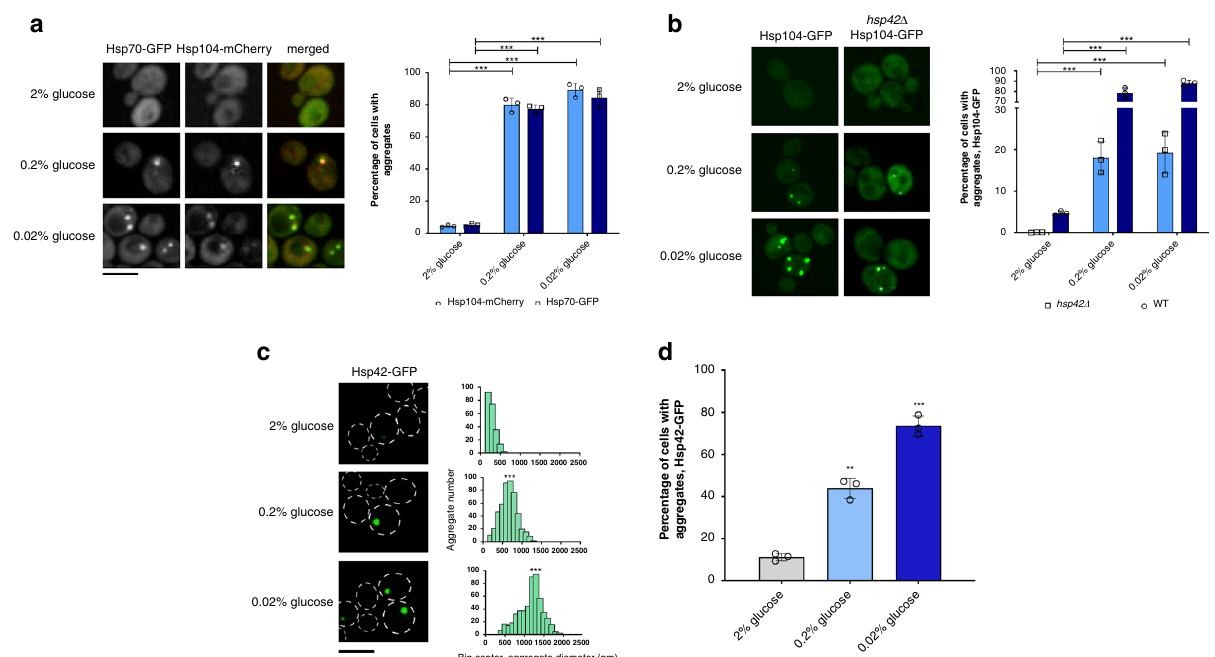
Fig. 4 Proteins are sequestered into Q-bodies during glucose starvation. a Hsp70 colocalizes with Hsp104 in aggregates formed during glucose starvation. The percentage of Hsp70-containing (Ssa1-GFP) aggregates is, on average, 76% in 0.2 and 85% in 0.02% glucose and corresponds to the abundance of Hsp104-mCherry aggregates. b In the hsp42 Δ strain, the percentage of cells with Hsp104-GFP aggregates is reduced in both 0.2% and 0.02% glucose. In a and b , n = 1100 cells were screened for aggregates starting from three independent exponential yeast cultures for each condition. Bar height represents mean ± SD from three separate cultures, each performed in triplicate. The mean of three technical replicates for each biological replicate is displayed as single data points. *** p < 0.001; ** p < 0.01; * p < 0.05 (one-way ANOVA plus Tukey post hoc). The images are representative of three biological replicates, each in three technical replicates. The black bar represents 8 µ m. c The number and the median diameter of Hsp42-bearing aggregates increase during starvation. Data represent binned values of individual aggregate diameters for n = 221, 494, and 541 aggregates from three independent exponential yeast cultures for each condition: 2%, 0.2% and 0.02% glucose, respectively. Kolmogorov – Smirnov test was used to compare the statistical signi fi cance of the observed differences between each studied condition and the control (2% glucose) (*** p < 0.001; ** p < 0.01; * p < 0.05). The images are representative of three biological replicates, each in three technical replicates. White dotted lines mark cell boundaries. The black bar represents 8 µ m. d The fraction of cells bearing at least one Hsp42-GFP aggregate increase from an average of 10% in control to 45% in 0.2% glucose and 70% in 0.02% glucose. N = 550 cells were screened for Hsp42-containing aggregates starting from three independent exponential yeast cultures for each condition. Bar height represents mean ± SD from three separate cultures, each performed in triplicate. The mean of three technical replicates for each biological replicate is displayed as single data points. *** p < 0.001; ** p < 0.01; * p < 0.05 (one-way ANOVA plus Tukey post